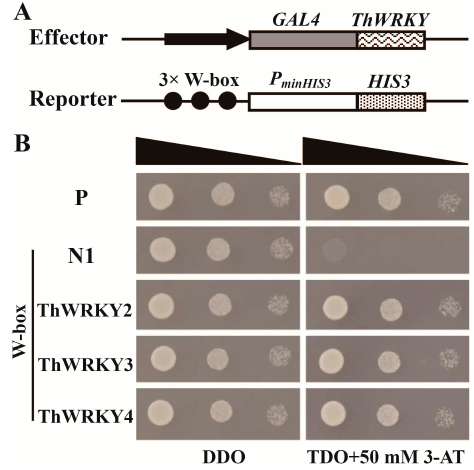
Figure 2. Analysis of the binding of ThWRKY2, ThWRKY3 and ThWRKY4 to the W-box motif in yeast. ( A ) Diagram of the reporter and effector vectors. Three tandem copies of the W-box were inserted into the pHIS2 vector as the reporter construct. The CDSs of ThWRKY s were cloned into pGADT7-Rec2 as the effector constructs; ( B ) The effector and reporter constructs were co-transformed into the yeast strain Y187. Positive transformants were further identified by spotting serial dilutions (1:1, 1:10 and 1:100) of yeast onto SD/–Leu/–Trp (DDO) and SD/–His/–Leu/–Trp (TDO) plates with 3-AT. P: positive control (p53HIS2 + pGAD-Rec2-53); N: negative controls (pHIS2-W-box + pGAD-Rec2-53).